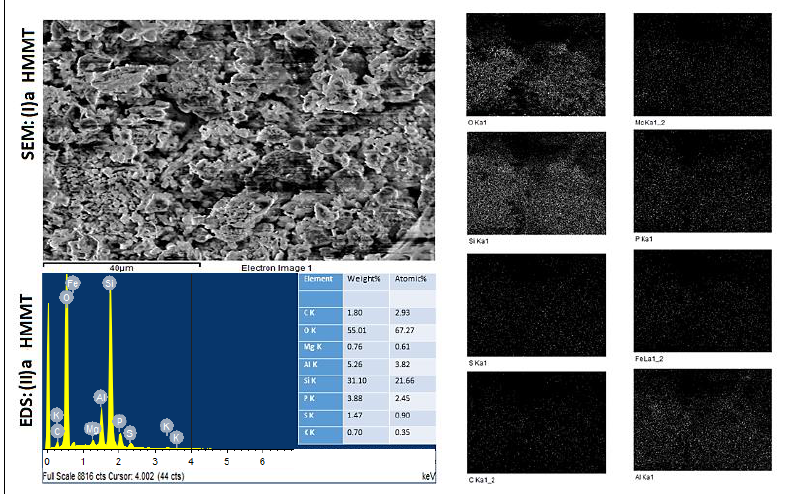
Figure 3. XRD patterns of HMMT, PANI – HMMT, CNx-HMMT, and